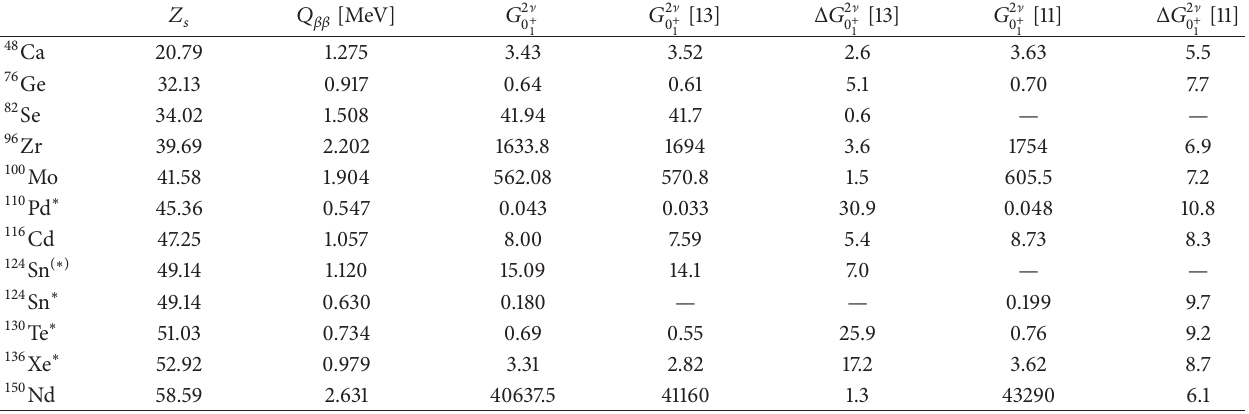
Table 2: PSF and their deviations for 2 ] 𝛽𝛽 to the first excited 0 + states and 𝐺 2 ] 0 + of [11] and their deviations. The results marked with “ ∗ ” and ( ∗ ) symbols (see text for details) correspond to the nuclei not included in the analysis.